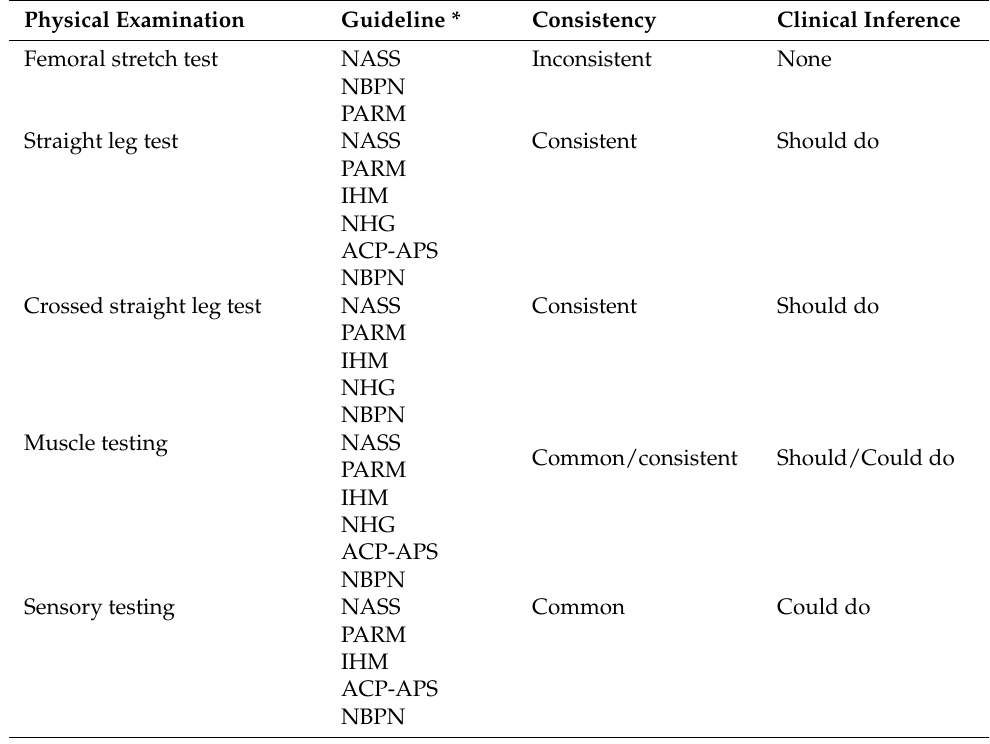
Table 4. Guideline recommendations for physical examination and other diagnostic